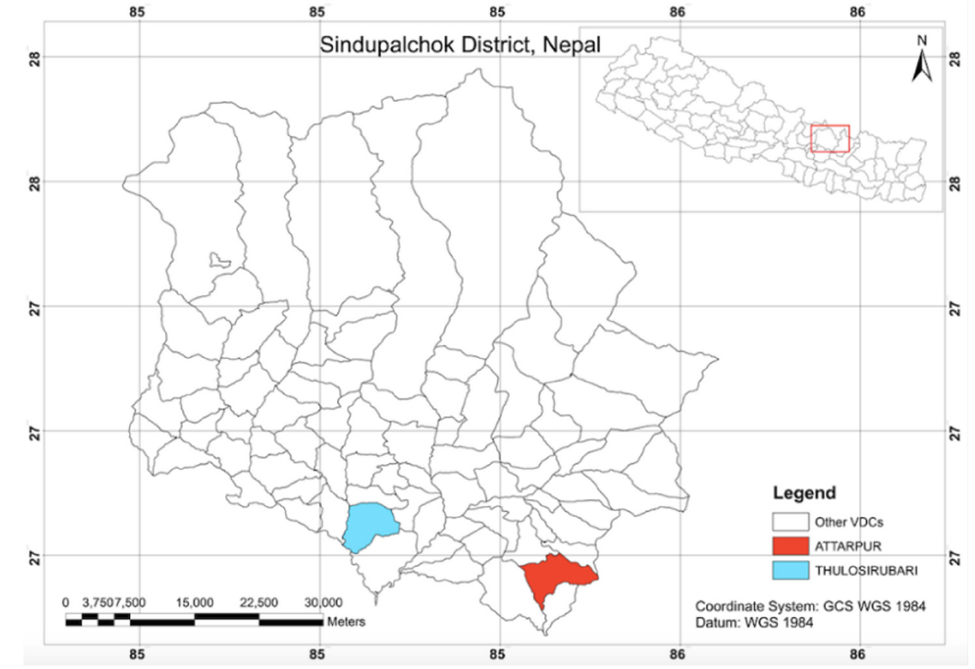
Figure 1. Location map of study area in the Sindhupalchok district.